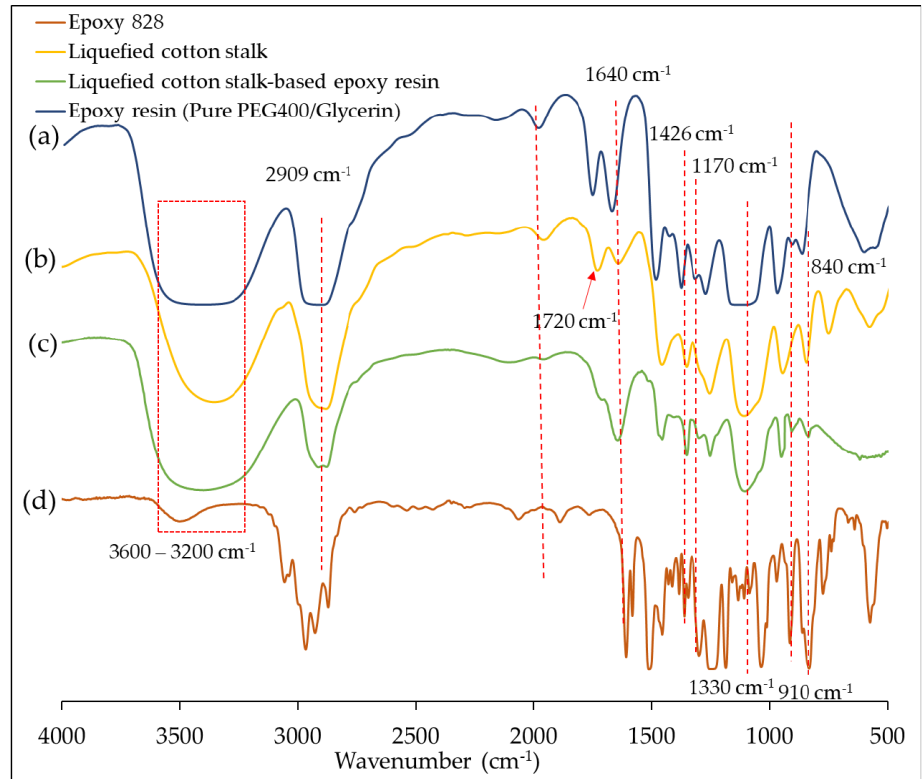
Figure 2. FTIR spectra of (a) pure PEG 400/glycerin-based epoxy resin, (b) liquefied cotton stalk, (c) liquefied cotton-stalk-based epoxy resin, and (d) commercial epoxy resin.